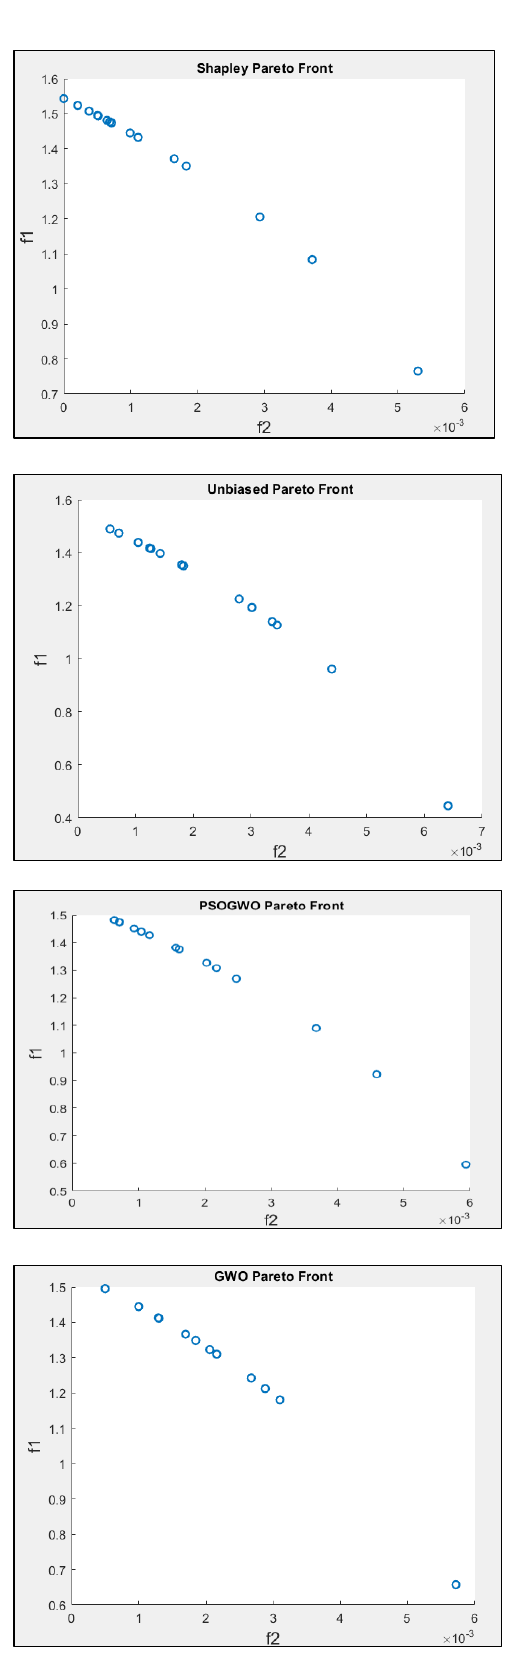
Table 1. Comparison of statistical results of energy efficiency and throughput of EHCRN. Objective Function